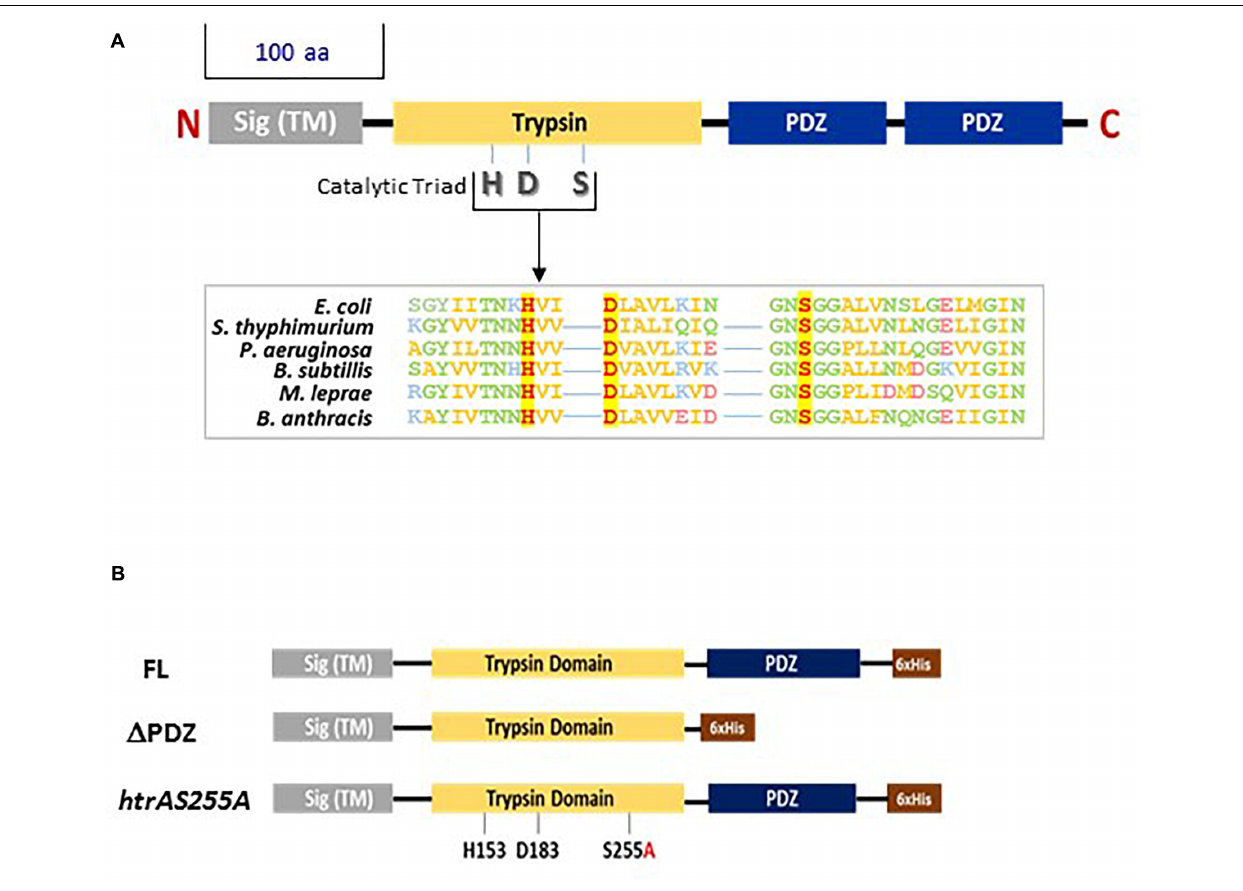
FIGURE 1 | (A) Schematic representation of bacterial serine proteases of the HtrA family. The highly conserved domains of the HtrA serine proteases are indicated. Sig (TM)-signal sequence and trans -membrane domain; Trypsin-the proteolytic domain. Bacterial HtrA proteases may exhibit one or two PDZ domains. The export signal peptide, trypsin and unique PDZ domain of HtrA BA as well as the H153, D183, and S255 residues forming the catalytic triad of the proteolytic domain were unambiguously identified by alignment with amino-acid sequences of 30 different bacterial serine proteases of the HtrA family using the T-coffee multiple sequence alignment program (Notredame et al., 2000; http://tcoffee.crg.cat). Similar alignments was previously documented (for example, Pallen and Wren, 1997; Kim and Kim, 2005; Singh et al., 2011). Boxed amino-acid sequence alignment: the high sequence conservation around the catalytic H, D, and S residues (shown in red with yellow background) is exemplified for six different bacterial HtrA serine proteases (hydrophobic residues are shown in yellow; polar non-charged residues are shown in green; positively charged residues are shown in blue; negatively charged residues are shown in pink). The respective bacteria are indicated on the left of the alignment. (B) Schematic description of the three forms of HtrA BA used in trans -complementation experiments for determining the role of the PDZ domain and the proteolytic activity of HtrA BA : full-length (FL), truncated ( (cid:49) PDZ) or mutated ( htrA S255A). The trans -complementation HtrA BA forms were engineered to exhibit a C terminal stretch of 6 histidine residues (6 × His, brown box) enabling zinc-affinity purification and Western blot visualization using anti-His